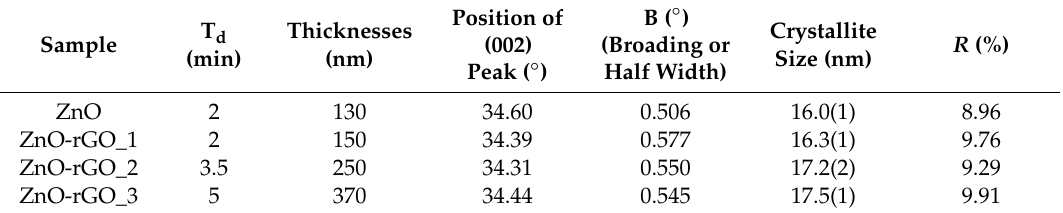
Table 1. Structural parameters of ZnO and ZnO-rGO thin